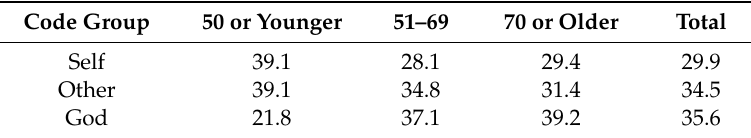
Table 11. Dimensions of everyday practices and personal context—age. Code